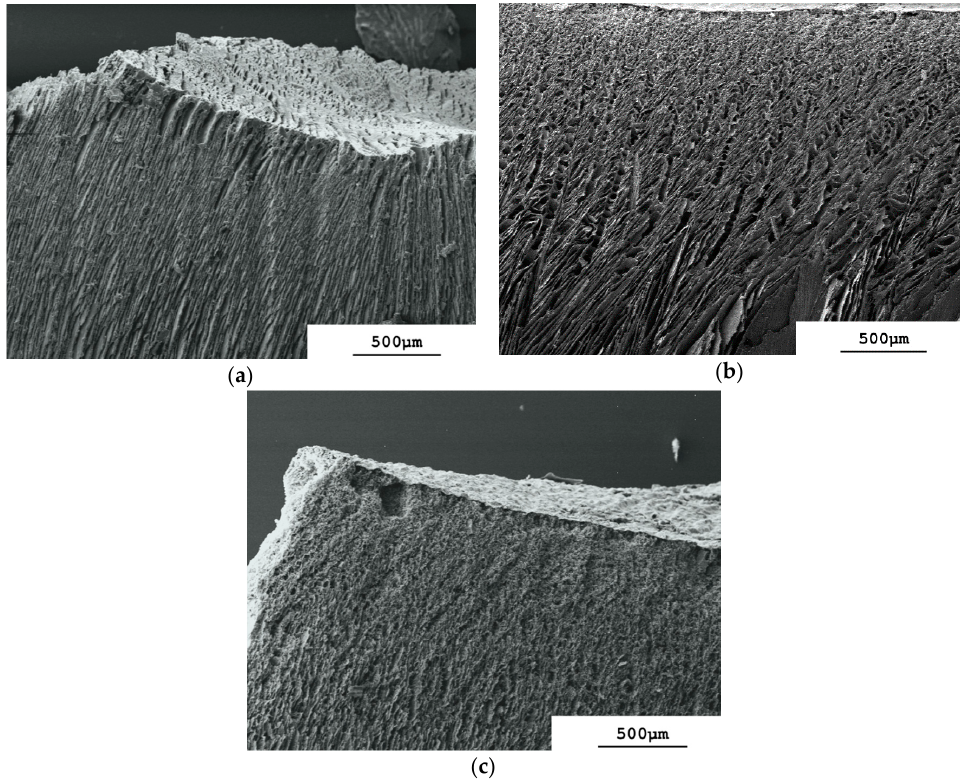
Figure 2. Scanning electron micrographs of longitudinal sectioned sintered monoliths to show surface and sub-surface structures. ( a ) φ v = 0.128; ( b ) φ v = 0.064; ( c ) φ v = 0.032.